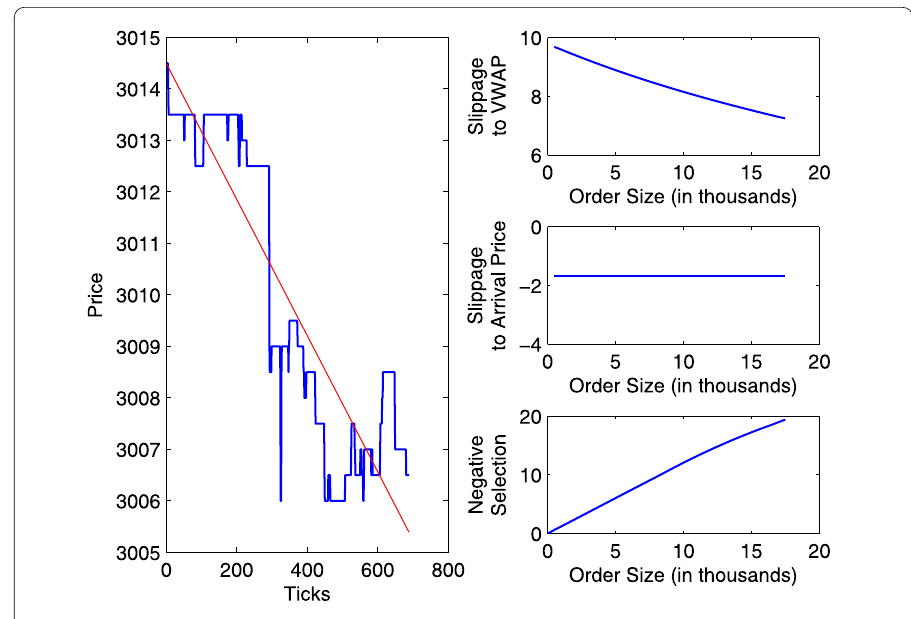
Figure 1 VWAP, Arrival Price and Negative Selection for falling market